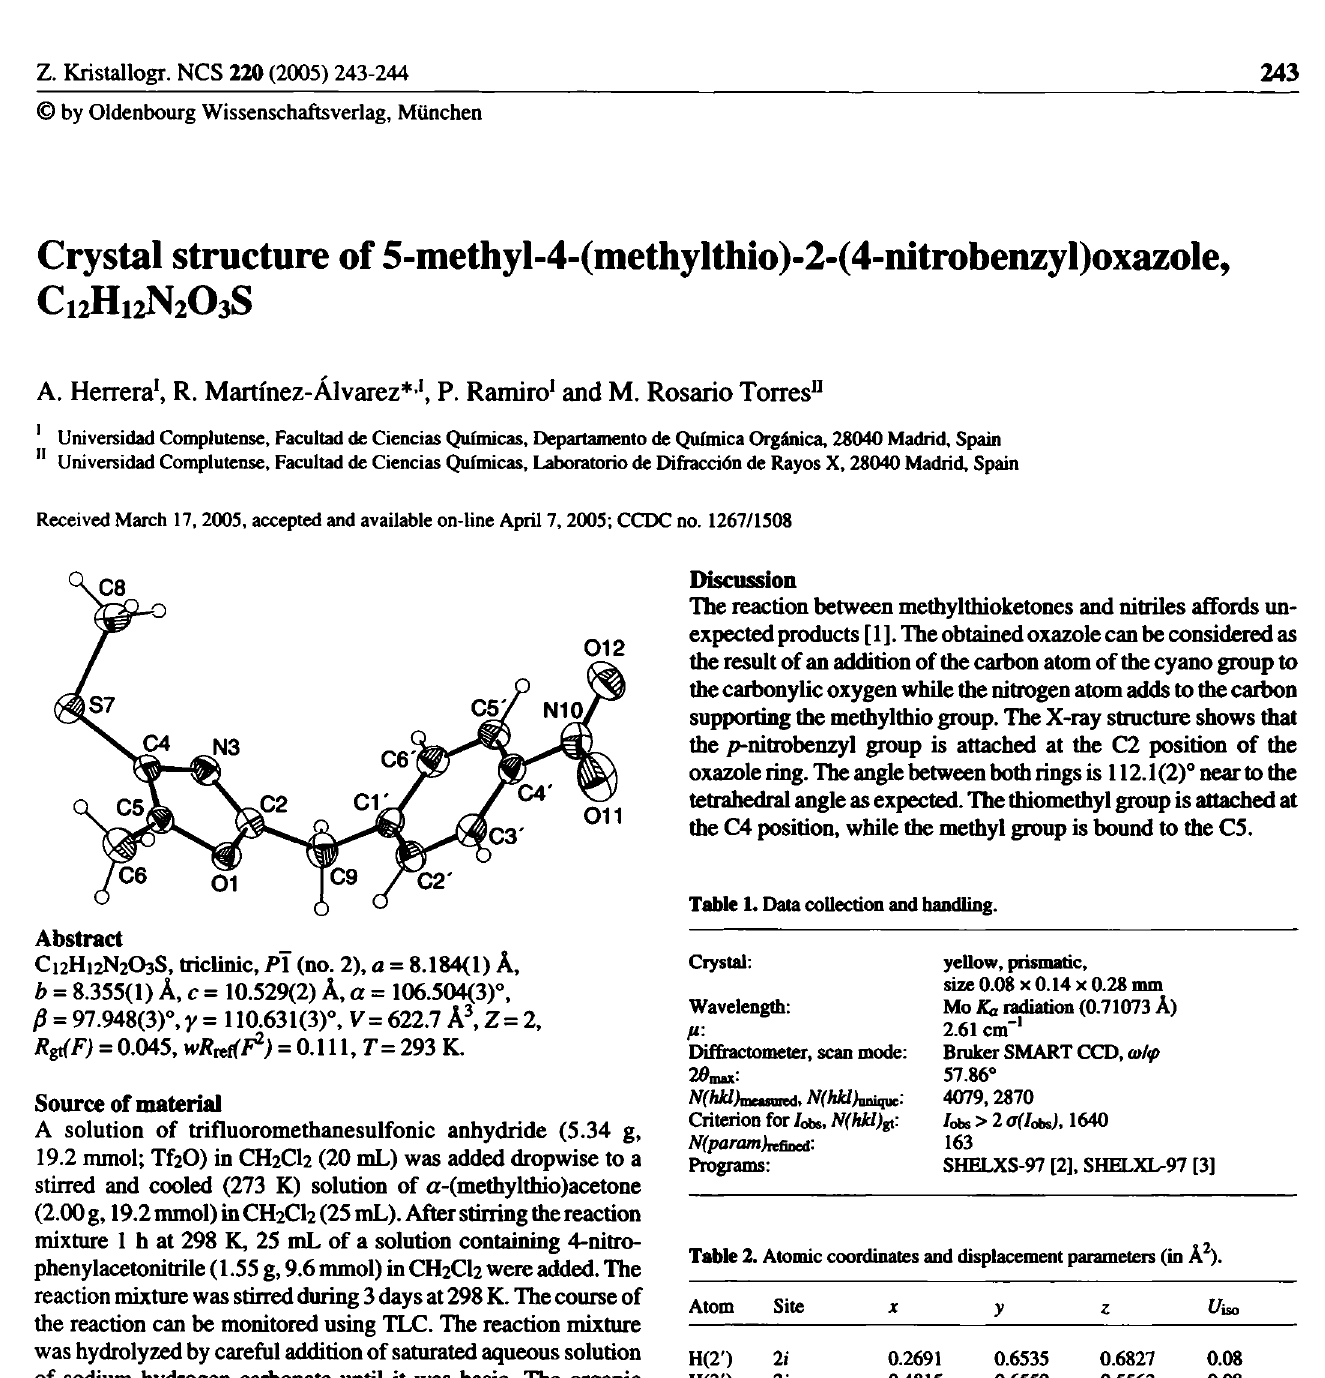
Table 3. Atomic coordinates and displacement parameters (in A 2 ).